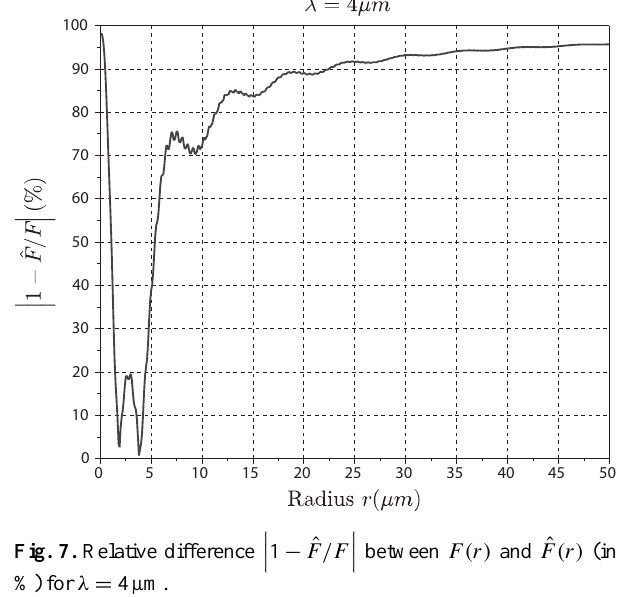
Fig. 6. As Fig. 5, for λ = 11µm.